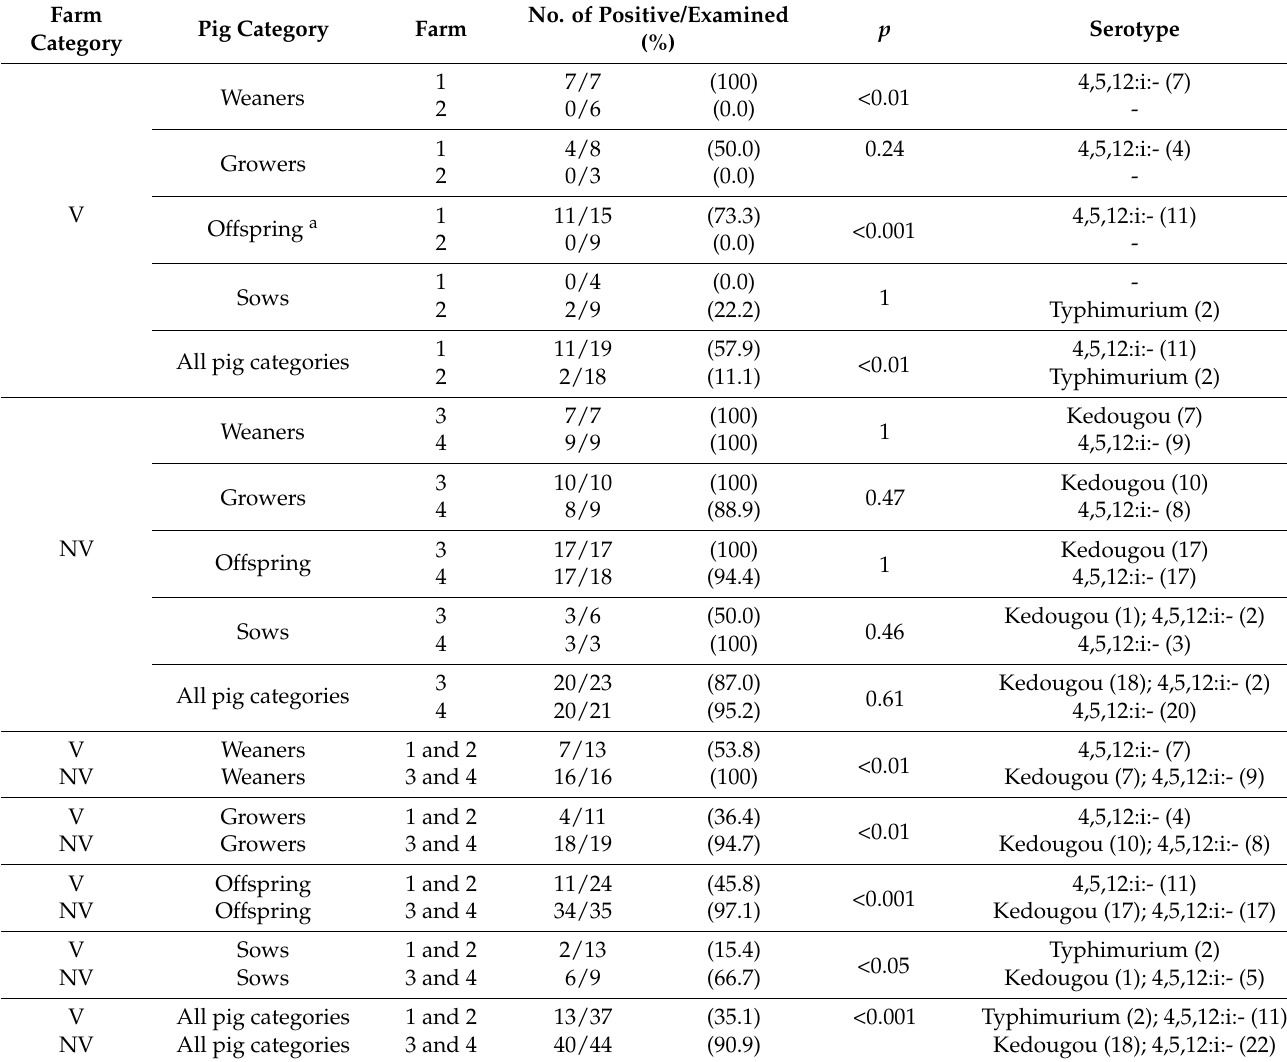
Table 3. Bacteriological results of samples collected from V and NV